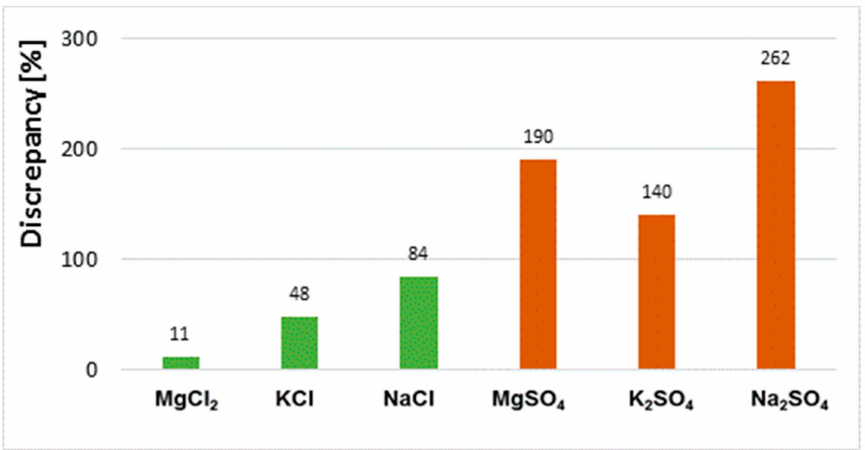
Figure 11. Discrepancy of results for chloride content in bricks exposed to MgCl 2 , KCl and NaCl salt solutions and for sulphate content in bricks exposed to MgSO 4 , K 2 SO 4 and Na 2 SO 4 salt solutions obtained in solid phase and aqueous